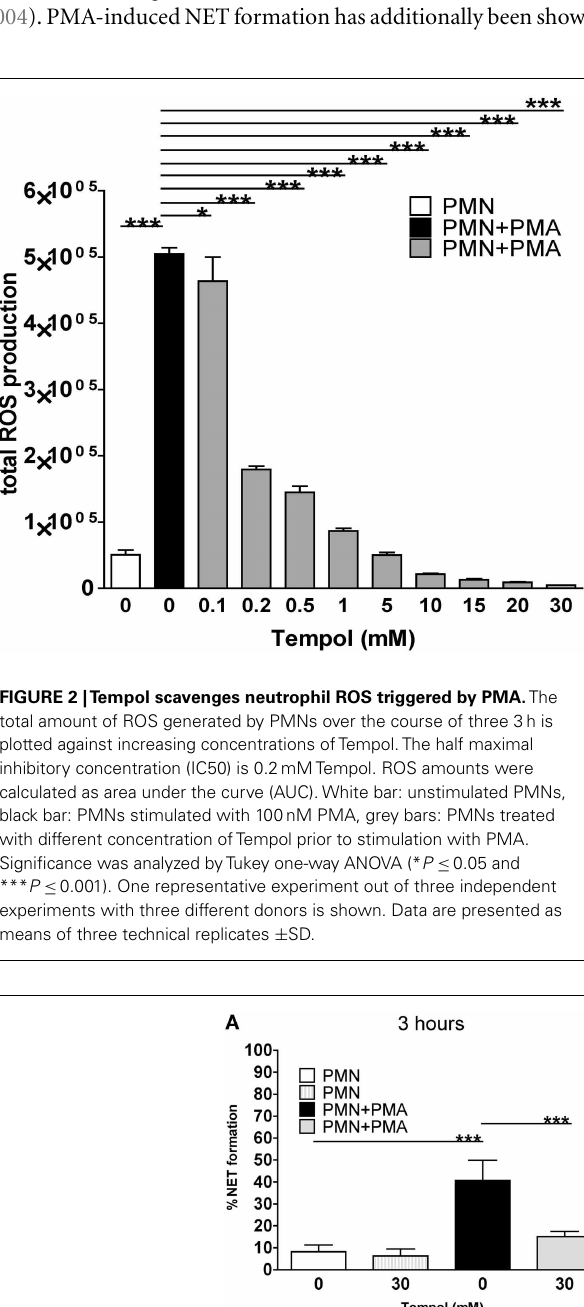
FIGURE 3 |Tempol prevents PMA-induced NET formation. Microscopic evaluation of NET formation by PMNs stimulated with 100nM PMA reveals reduced formation of NETs in the presence ofTempol. Percentage of NET formation after 3h (A) and after 6h (B) .White bars: unstimulated PMNs, dashed gray bars: PMNs treated withTempol only (30mM), black bars: PMNs